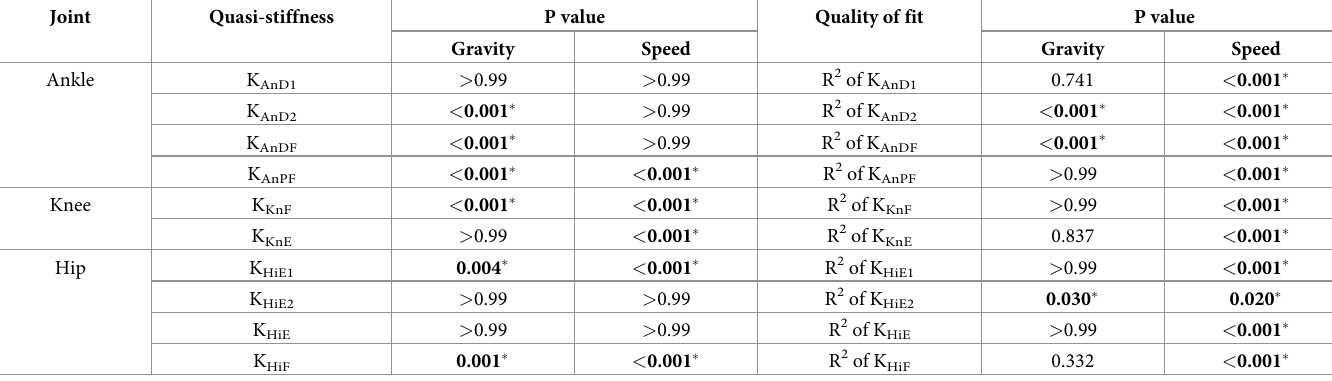
Table 3. Post-hoc significance of gravity level and speed on quasi-stiffness and fits.